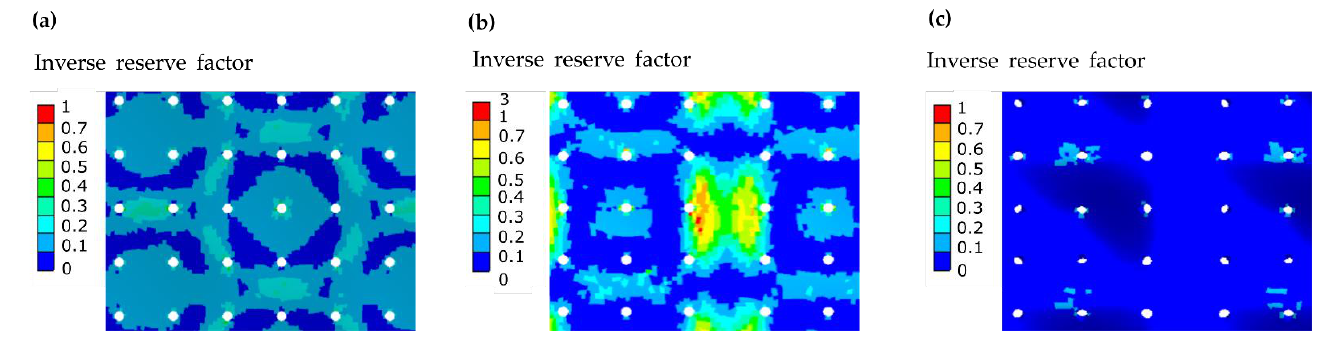
Figure 11. Workload of the perforated face sheets of the liner models ( a ) HR liner, ( b ) FHR liner with carbon fiber, ( c ) FHR liner with PA6-GF.